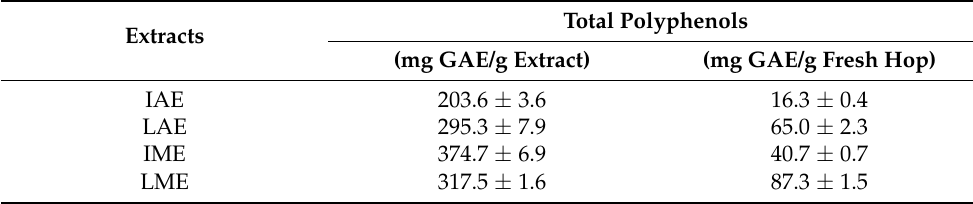
Table 5. Polyphenols of Chinook hops inflorescences and leaves.